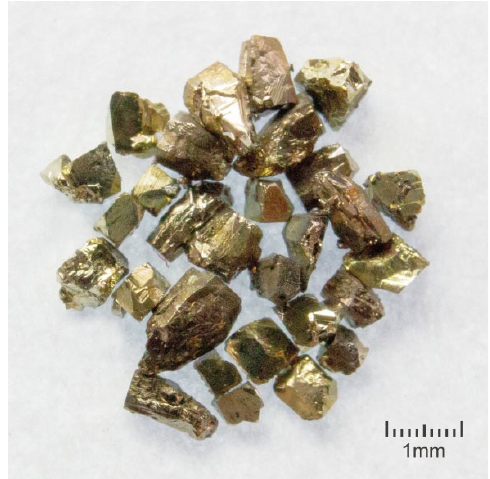
Figure 1. Crystals of associated pyrite and pyrrhotite displaying a prevailing crystal habit (synthesis conditions—400 °C, 1 kbar, 10 % NH 4 Cl